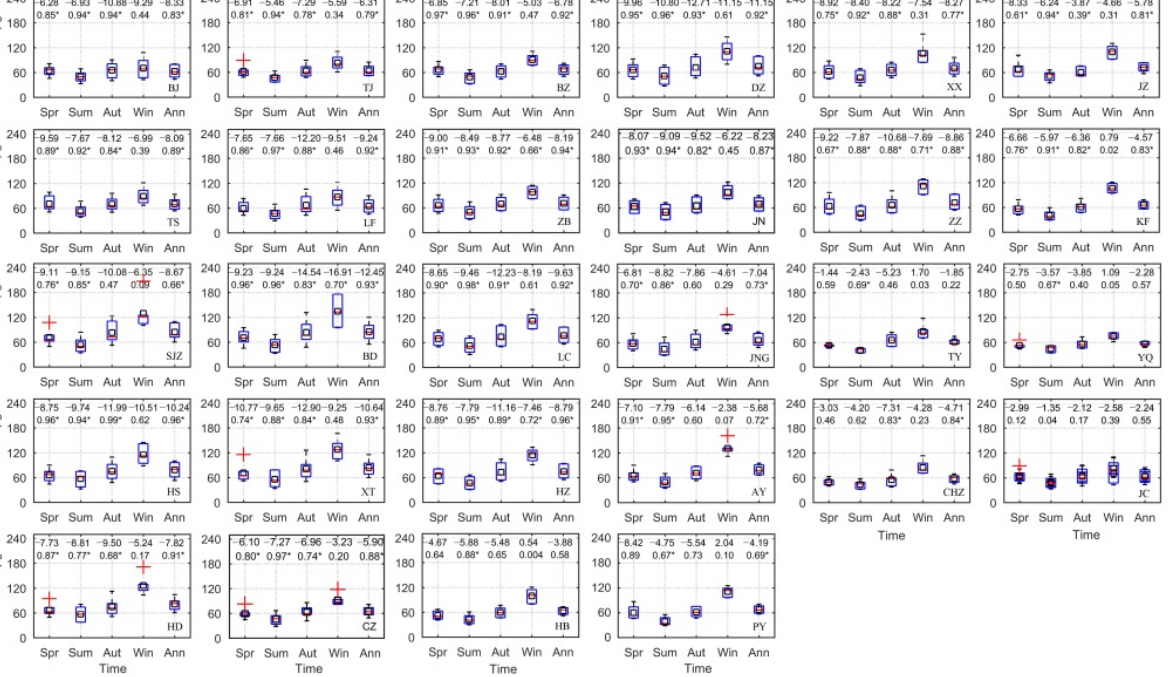
clear spatial agglomeration characteristics, with H–H spatial clusters from Dezhou in 2015, to Handan Anyang, Hebi and Puyang in 2019. The L–L spatial clusters appeared in Beijing and Tianjin and persisted thereafter (Figure